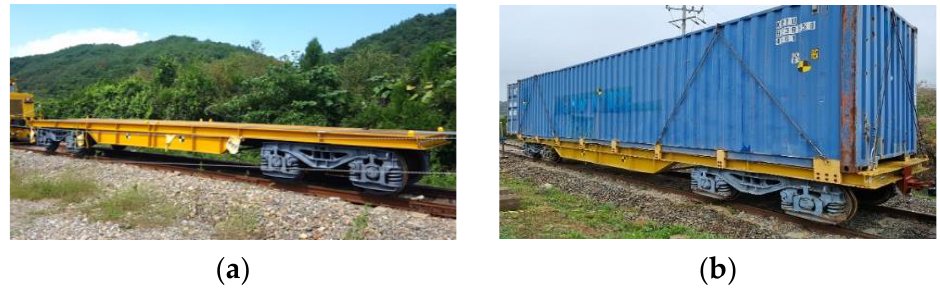
Table 1. The dimension information of the concrete track and DCP.